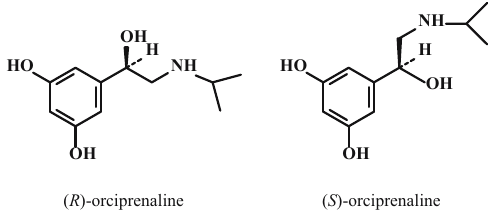
Figure 1: Two stereoisomers of